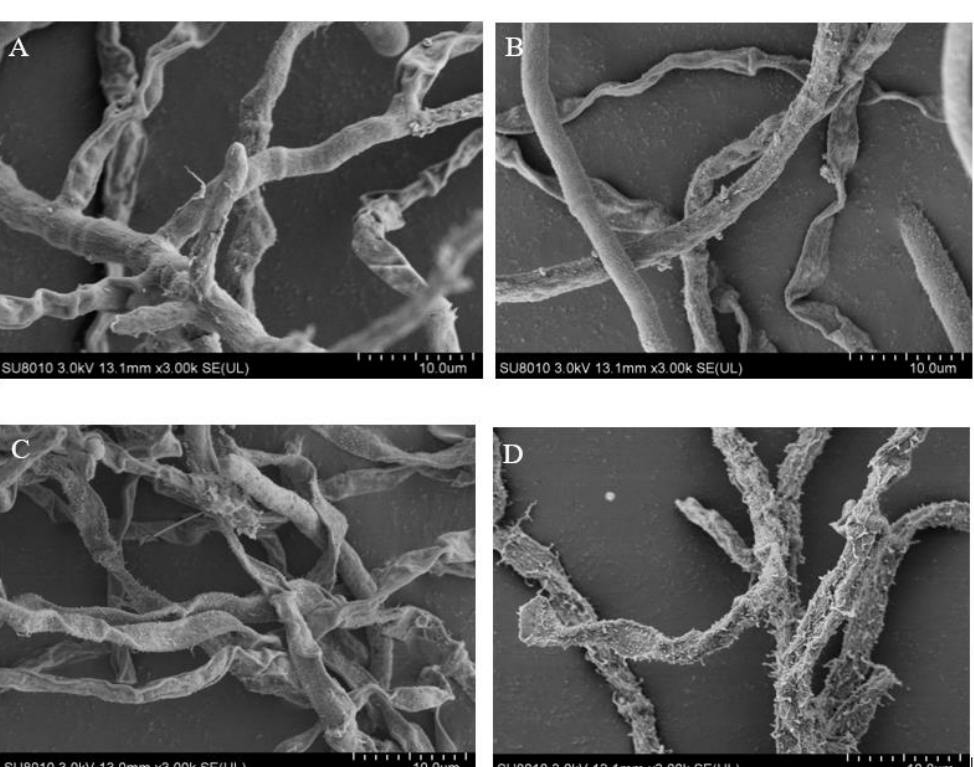
Figure 2. Effect of CV on mycelia structures from A. flavus . ( A ) Control group, ( B ) 50 μg/mL , ( C ) 100 μg/mL and ( D ) 200 μg/mL .